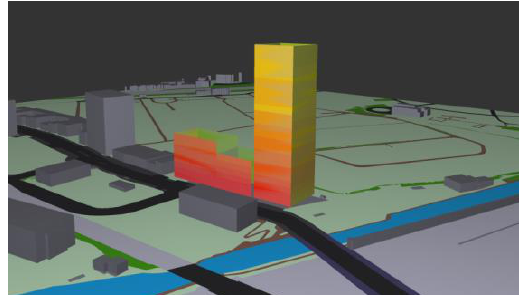
Figure 9 The noise model with the semi-transparent simplified